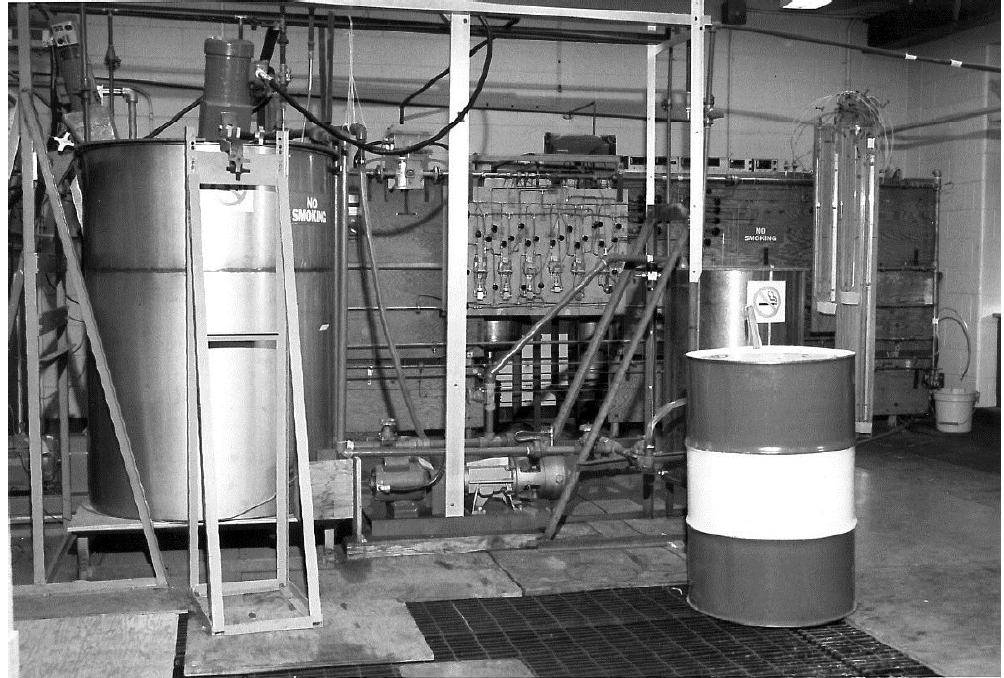
Figure 2. Front view of the flow